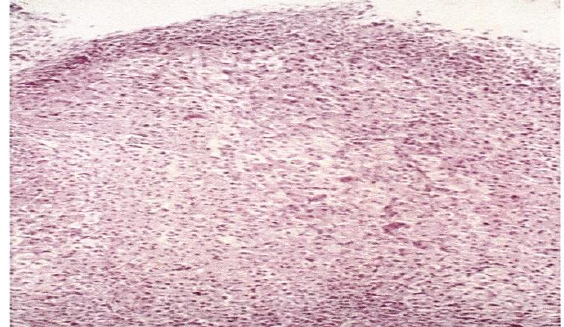
Figure, 1: Fetal goat adrenal gland ,CRL/12cm= 70 day ;Section show thin capsul with zona glouerlosa , there is no demarcation between the zona fasculata and zona reticulars ( M. H. X80).